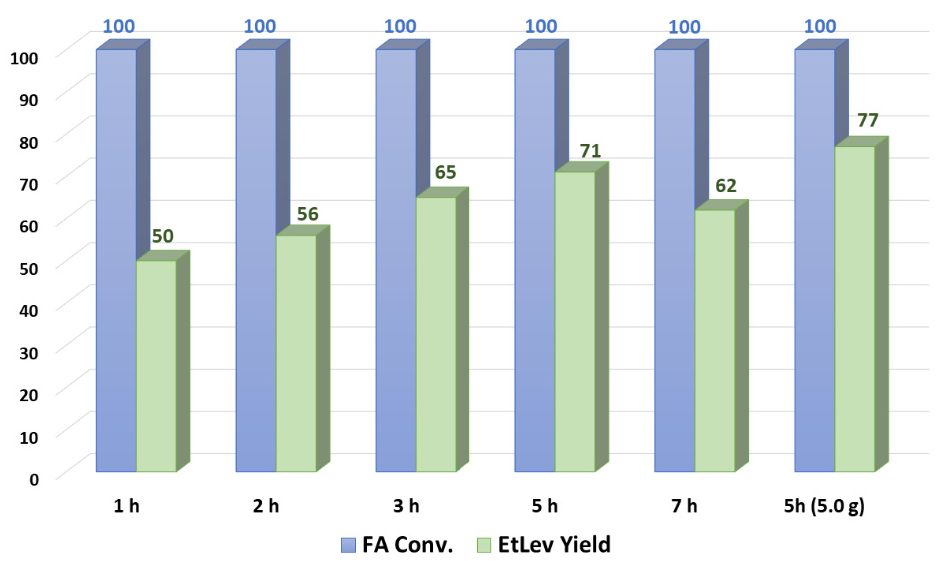
Figure 2. Synthesis of ethyl levulinate over time.